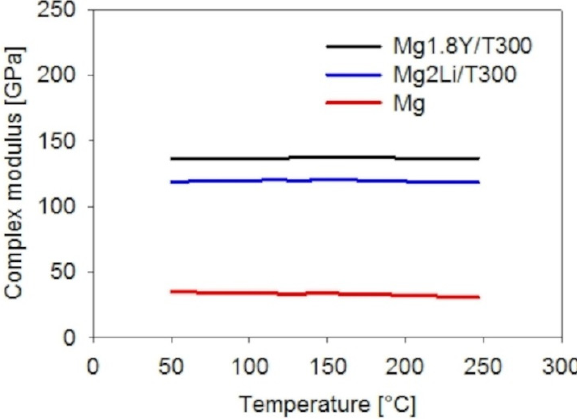
Figure 14. Complex modulus of the composites with the T300 fibers. Table 2. Dynamic Young’s modulus values of Mg-based T300 and Mg-based Granoc